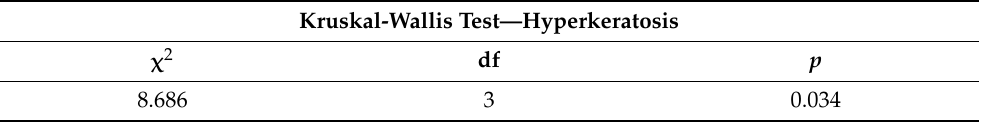
Table 7. Kruskal-Wallis test and pairwise comparisons for the variable “hyperkeratosis”.